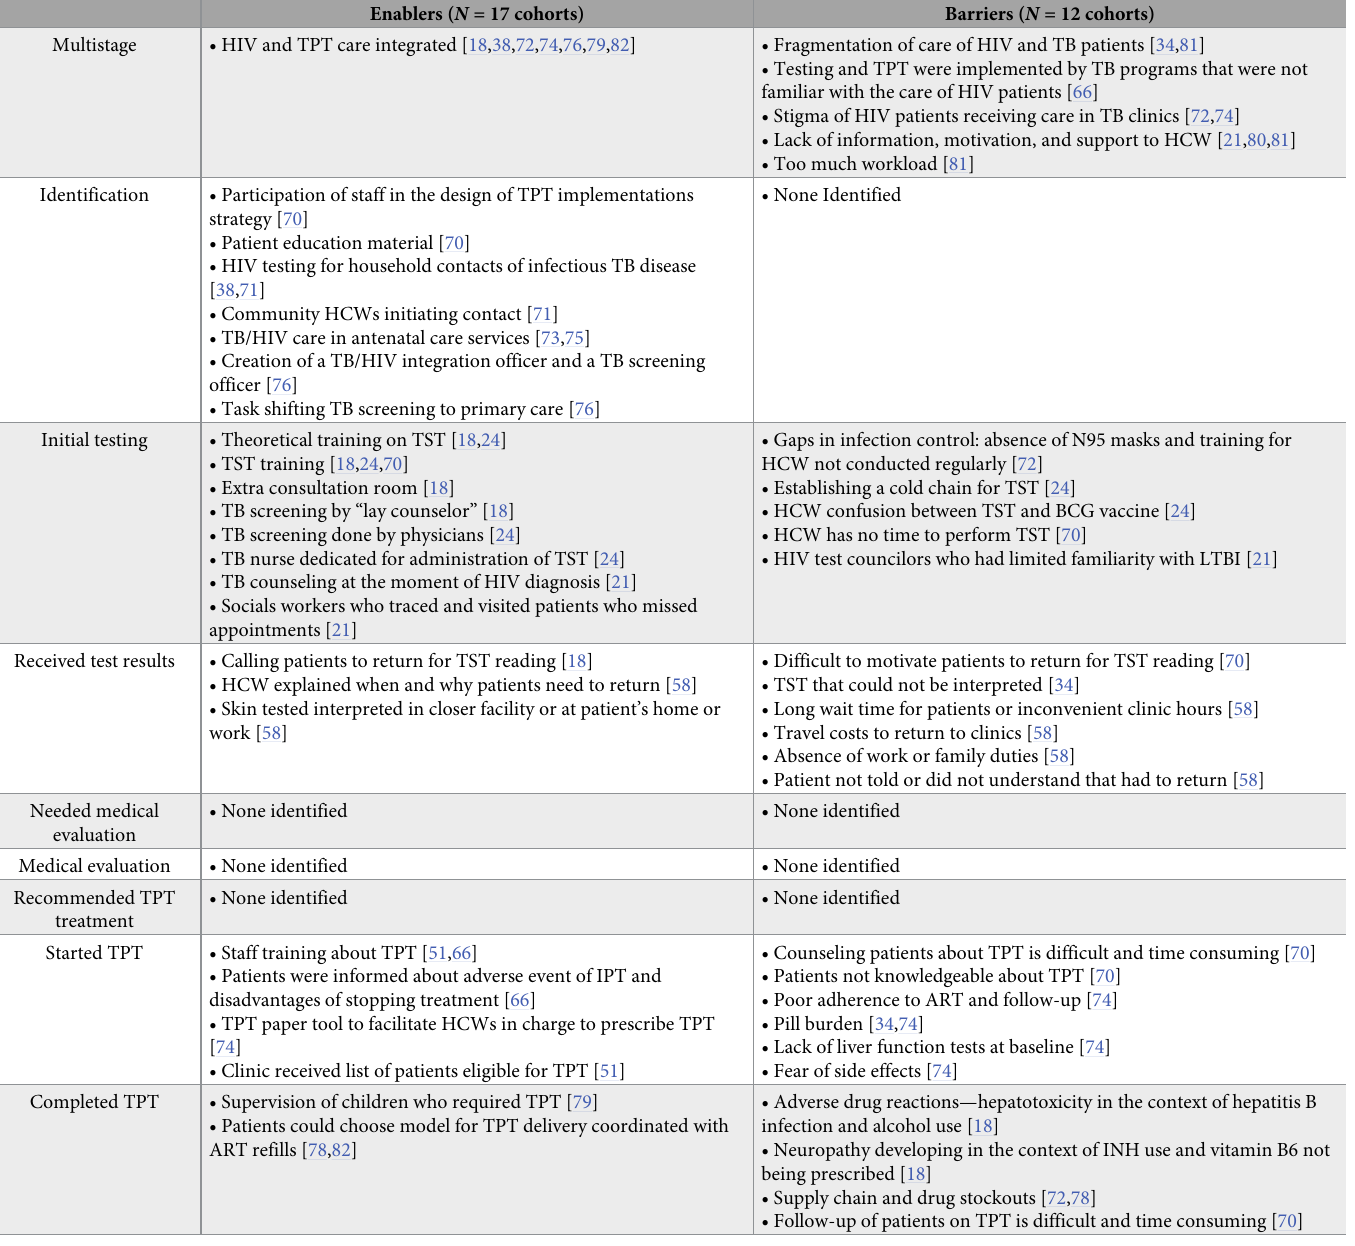
Table 4. Enablers and barriers for different steps of the cascade-of-care identified in the studies included in the review. Enablers ( N = 17